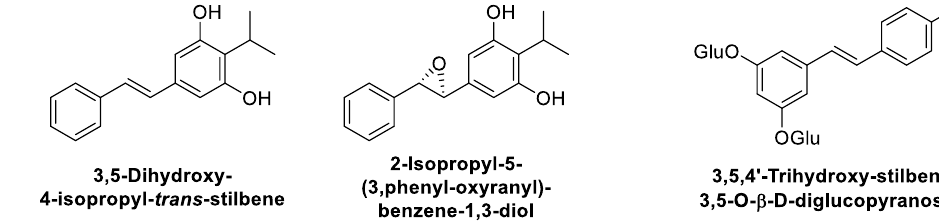
Figure 1. Structures of monomeric stilbenoids.